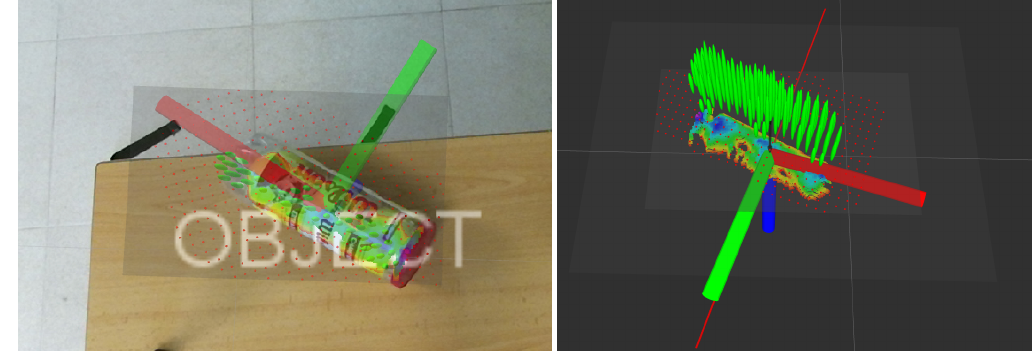
Figure 5. HAF visualization for the tennis ball container: ( left ) view from the Kinect 2.0; ( right ) view from Baxter.